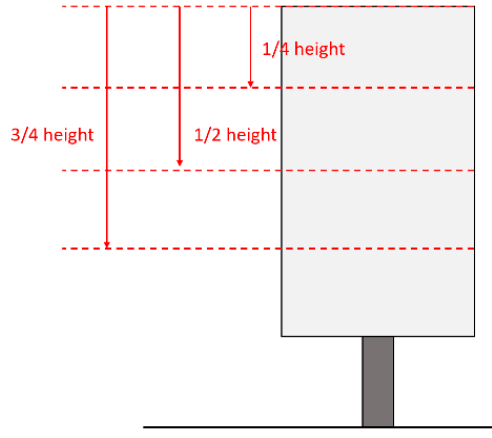
Figure 6. Planes to extract the sections of the structures of rectangular ( a ) and decagonal ( b ) structures.